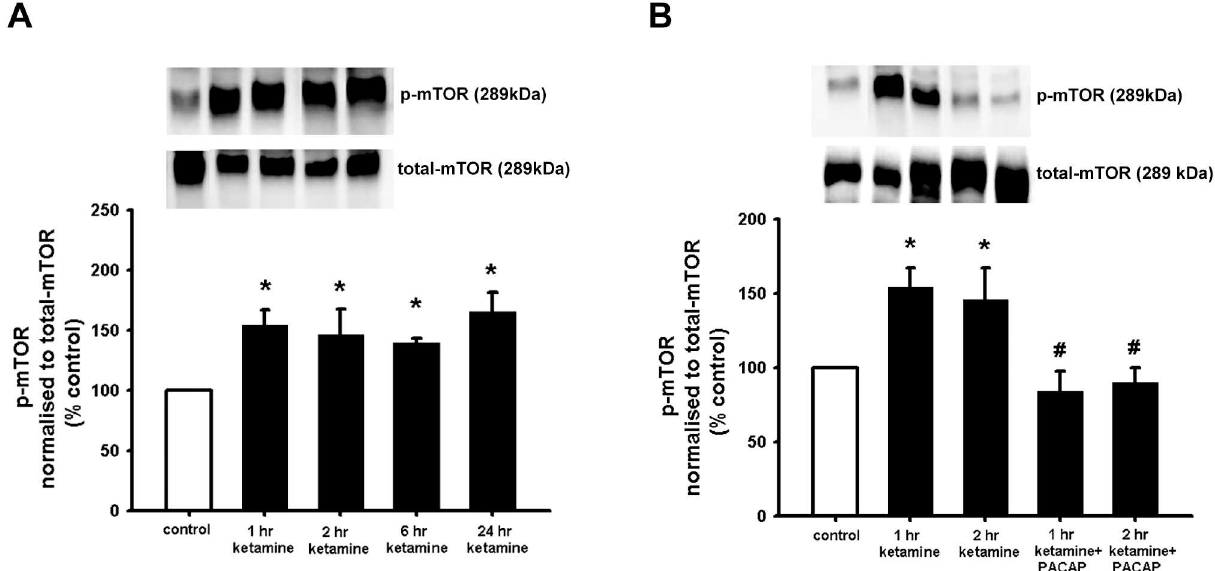
Fig 5. PACAP counteracts ketamine induced mTOR activation. NSCs were plated as singlecells and treated with 400 μ M alone or with 100 nM PACAP and 400 μ M ketamine. Cells were treated as indicatedand after 1, 2, 6 and 24 hour incubation cells were harvestedfor Western blot experiments (A) . Cells were treated as indicatedand incubatedfor 1 and 2 hours and harvestedfor Western blot experiments (B) . To obtain quantitative measurements p-mTOR were normalized against total-mTOR. Data are shown as mean ± SEM (A, n = 4–8; B, n = 3–5). Kruskal-Wallis followedby Dunn’stest or Fisher LSD test was used. Differences were considered significantat P < 0.05. * denotes P < 0.05comparedwith control, # denotesP < 0.05 comparedto ketamine + 1 hour or ketamine+ 2